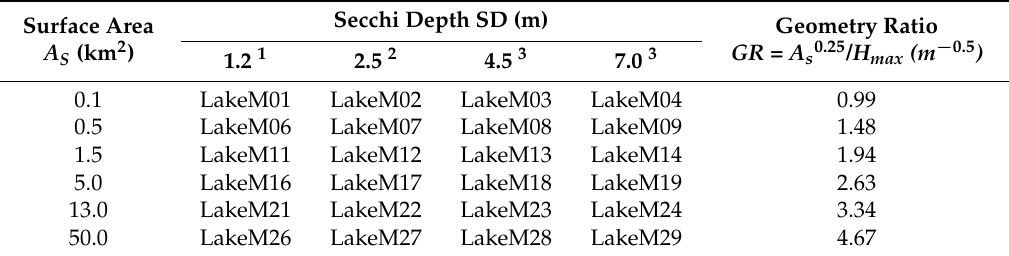
Table 2. Morphometric characteristics and “names” of the 24 medium-deep virtual lakes simulated with the MINLAKE2012 model (maximum lake depth H max = 18 m).